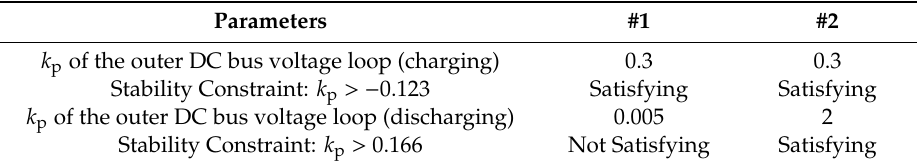
Table 2. The experiment parameters of system.